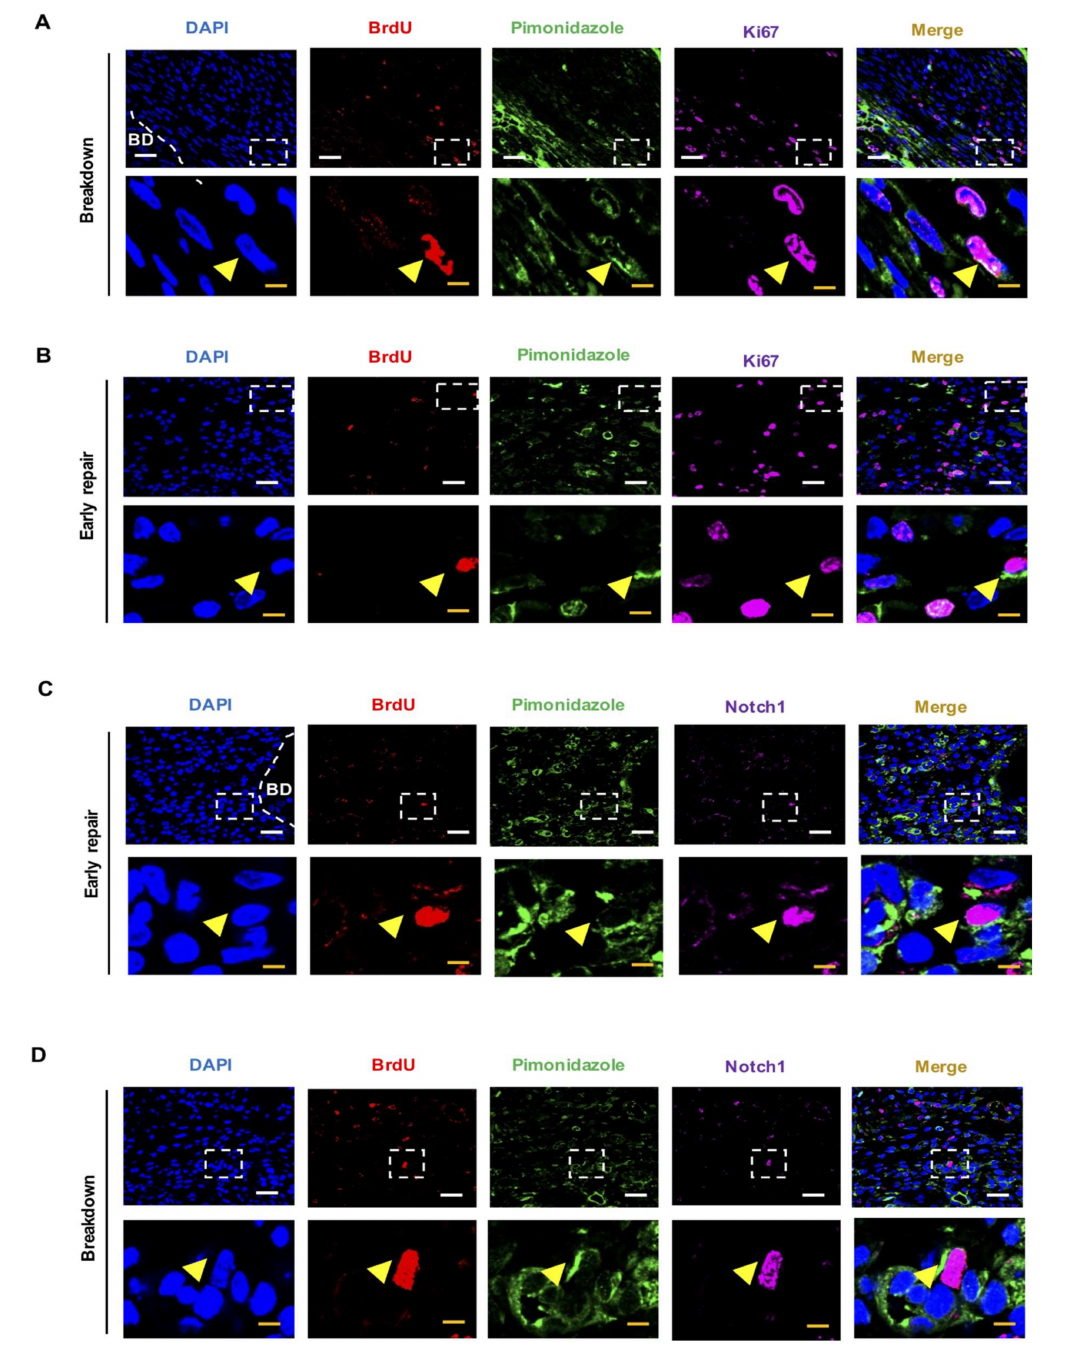
Figure 2. Characterization of LRSC localized in the hypoxic microenvironment during breakdown and early repair. Representative immunofluorescence images showing colocalization of the hypoxic LRSC with the proliferating marker Ki67 (yellow arrow) at ( A ) breakdown and ( B ) early repair. Hypoxic LRSC colocalizing with Notch1 (yellow arrow) at ( C ) breakdown and ( D ) early repair. Lower panels are enlarged figures of white box in the upper panels. Scale bar: upper panel 20 µ m; low panel 5 µ m. n = 3–5 mice per group. Abbreviations: BrdU, bromodeoxyuridine; BD, breakdown; LRSC, label-retaining stromal